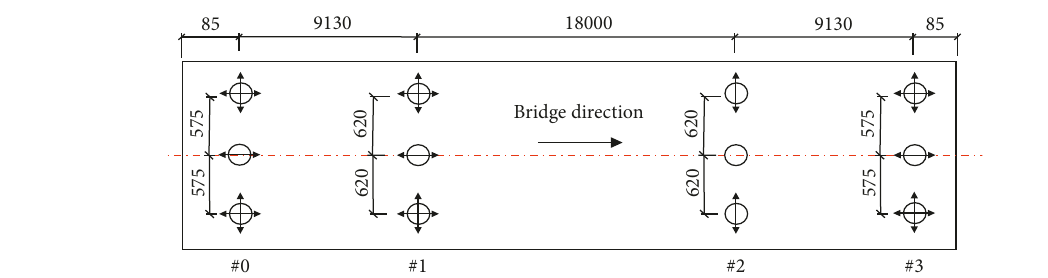
Figure 15: Bridge bearing layout (unit: